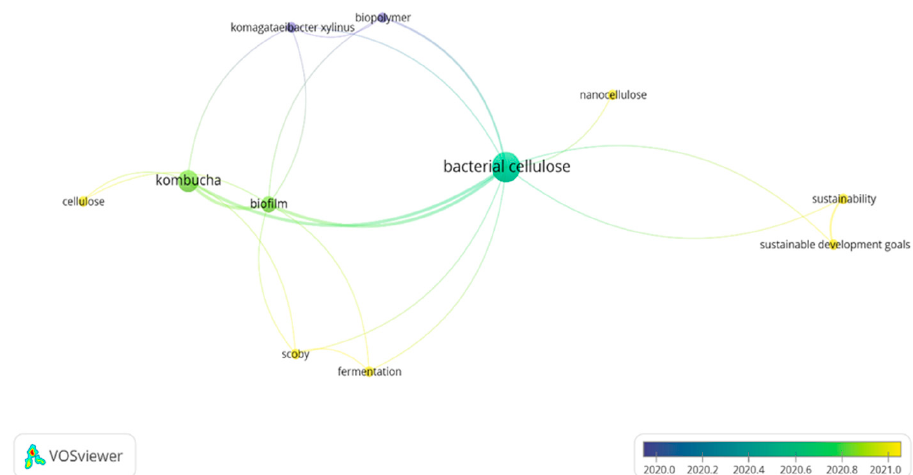
Figure 5. Co-occurrence among the most used terms among the 42 research articles. Source: authors, 2022.